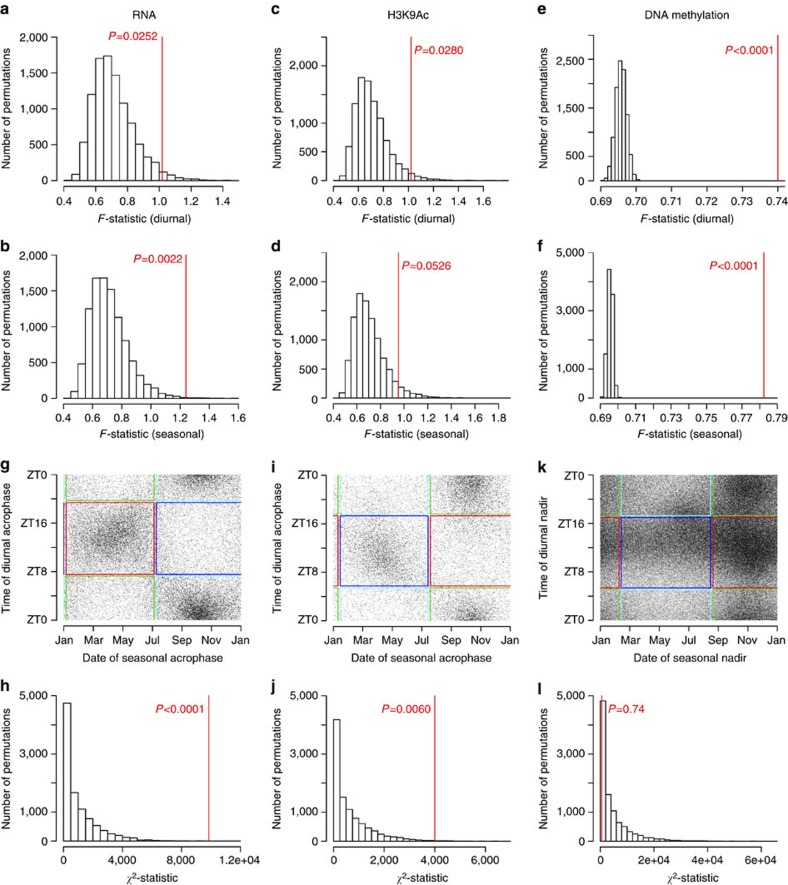
Diurnal and seasonal rhythmicity in the transcriptome and epigenome.(a) Observed (red) versus expected (black) median F-statistic for diurnal rhythmicity considering all transcripts together. Null distribution estimated by consideration of 10,000 empiric null data sets generated by randomly shuffling times of death. (b) As in a but for seasonal rhythms. (c,d) As in a,b but for H3K9Ac peaks. (e,f) As in a,b but for DNA methylation sites. (g) Association between time of diurnal versus seasonal acrophases. Each dot represents a single transcript. Coloured boxes depict empirically derived clusters. (h) Observed (red line) versus expected (black bars) χ2-statistic for association between timing of diurnal and seasonal rhythms. Expected distribution empirically derived from 10,000 permuted null data sets generated by randomly shuffling times and dates of death. (i,j) Same as in g,h but for H3K9Ac peaks. (k,l) Same as in g,h but for the diurnal and seasonal nadirs of individual DNA methylation sites. See also Supplementary Figs 3–5.